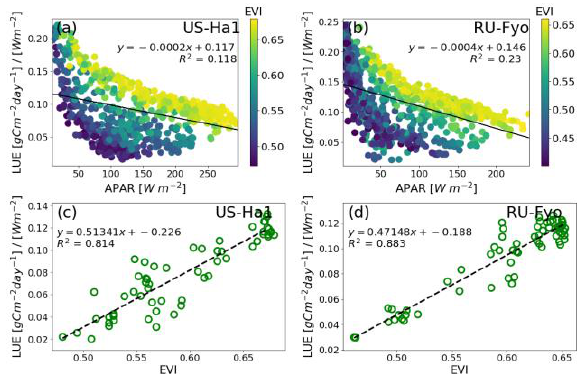
Figure 6. Simulated relationships between daily APAR and LUE during all seasons (a and b) and simulated LUE-EVI relationships with APAR between 130 W m-2 to 150 W m-2 (c and d) for US- Ha1 and